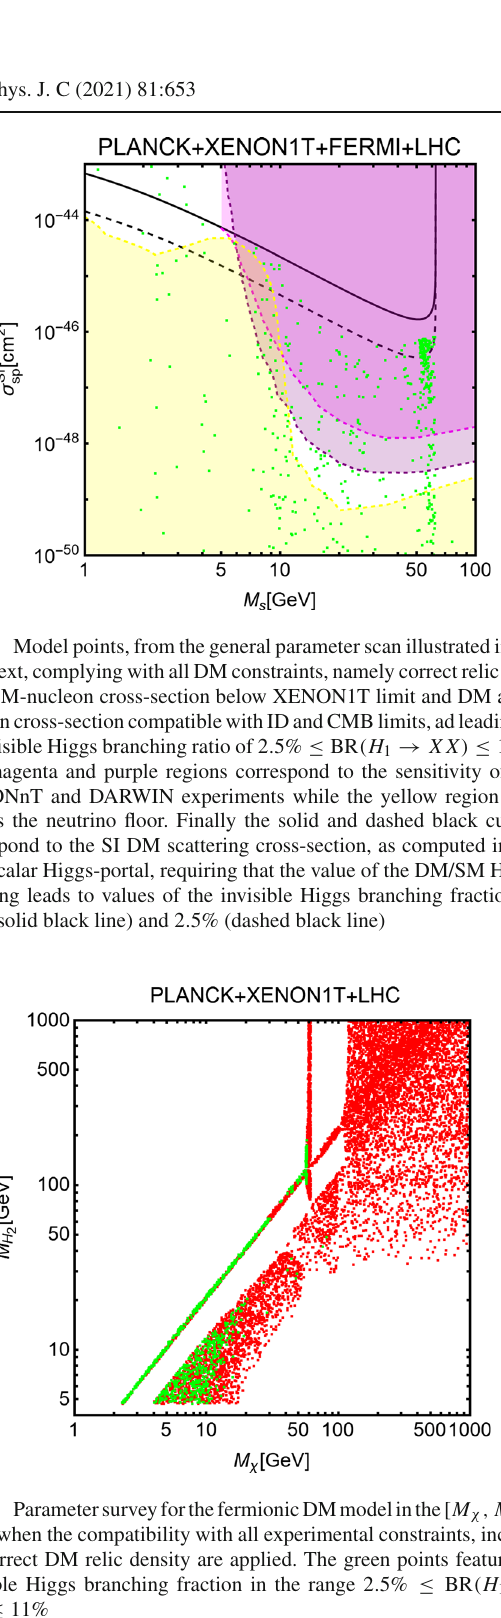
We notice, however, that the contour for the invisible Higgs branching fraction is independent of the DM mass and is still M H . This is due to the fact that present for M χ > 1 2 1